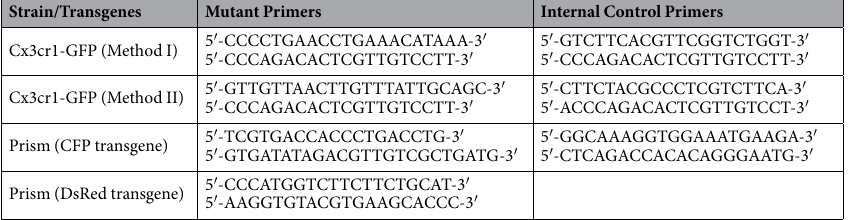
Table 1. List of primers used for